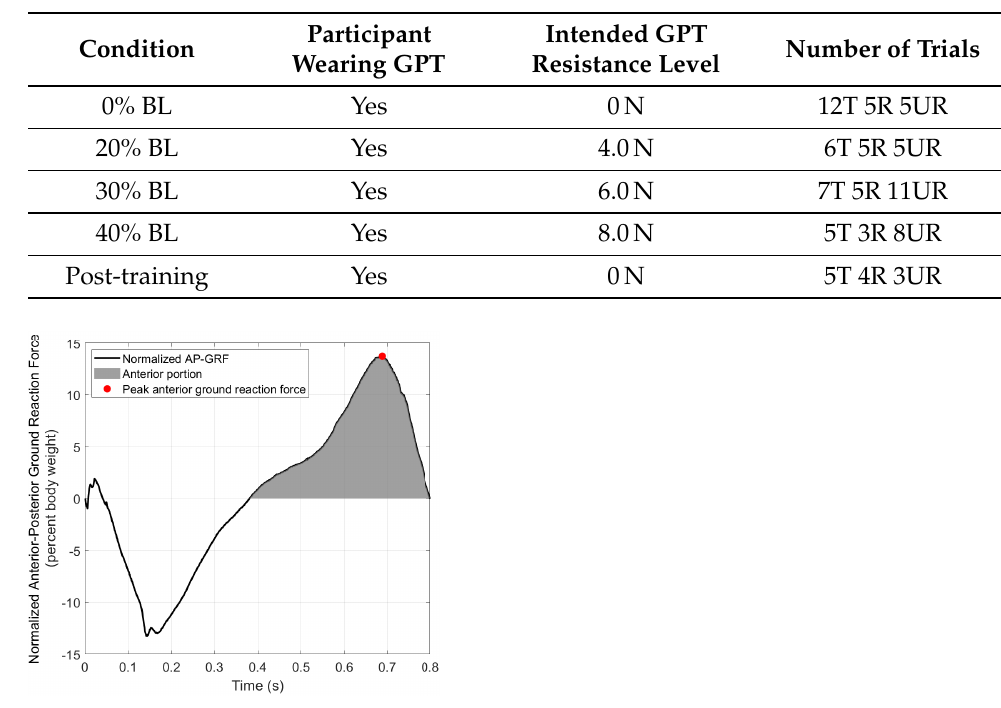
Table 2. Tested conditions with the stroke participant in the pilot study, BL = 19.8N.